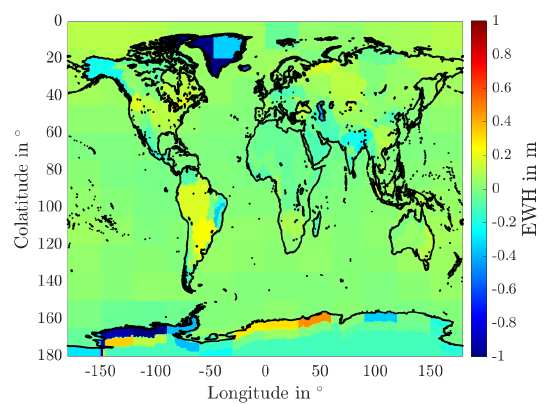
Figure 4. Original JPL GRACE mascon solution [24] for June 2017 averaged to a grid of a total of 333 mascons based on which the synthetic GOCE SGG data has been generated. The mascon grid is composed of 130 ocean mascons on a 30 ◦ -by-15 ◦ grid, 3 mascons in Greenland, and 24 mascons in Antarctica, as well as 176 mascons on the remaining continents which are assembled based on river catchment